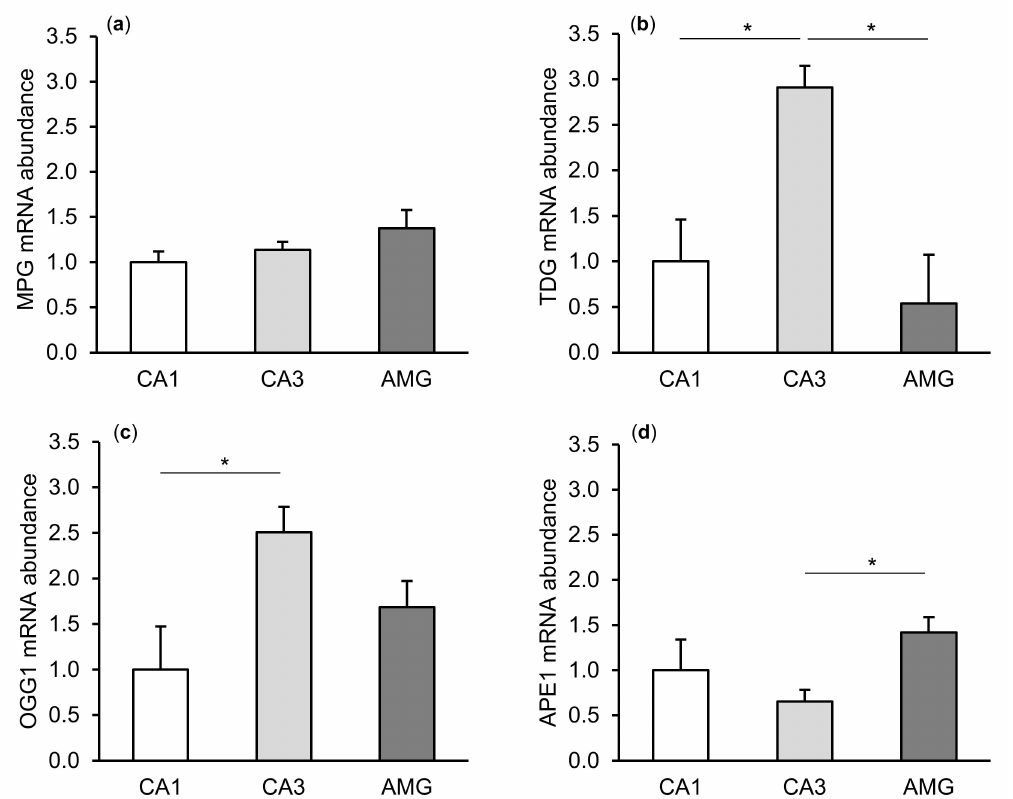
Figure 1. Relative mRNA abundance (mean ± SEM) of N-methylpurine-DNA glycosylase (MPG), ( a ) thymine-DNA glycosylase (TDG), ( b ) 8-Oxoguanine glycosylase (OGG1), ( c ) and AP-endonuclease 1 (APE1), ( d ) in the hippocampal CA1 and CA3 fields, as well as in the central amygdaloid nucleus (AMG) of the control group. Significance of di ff erences: * p <